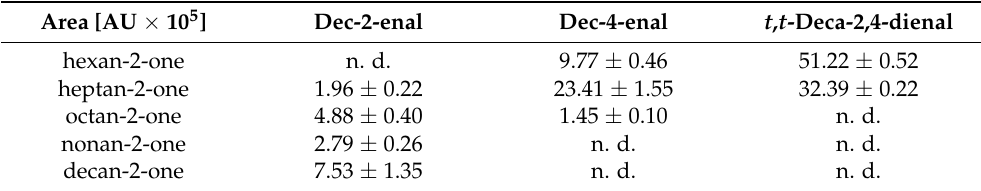
Table 9. Peak areas of methyl ketones from dec-2-enal, dec-4-enal, and deca-2,4-dienal (0.05% in paraffin oil) with PE, heated at 160 ◦ C for 20 min and analyzed by HS-GC-MS; n. d. not detected. Area [AU × 10 5 ] Dec-2-enal Dec-4-enal t , t -Deca-2,4-dienal hexan-2-one n. d. 9.77 ± 0.46 51.22 ± 0.52 heptan-2-one 1.96 ± 0.22 octan-2-one nonan-2-one